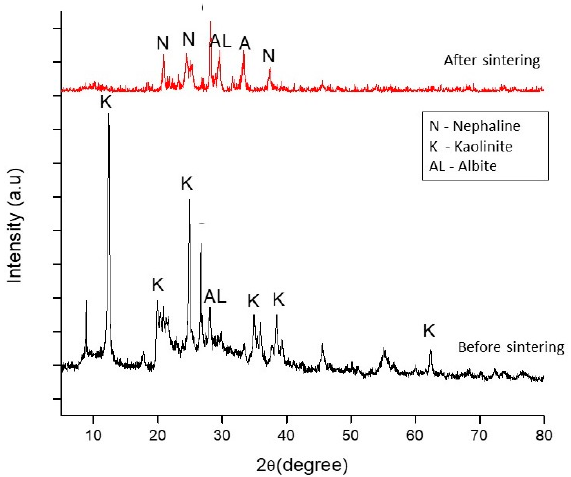
Figure 7. Phase analysis of kaolin-GGBS geopolymer before and after sintering.